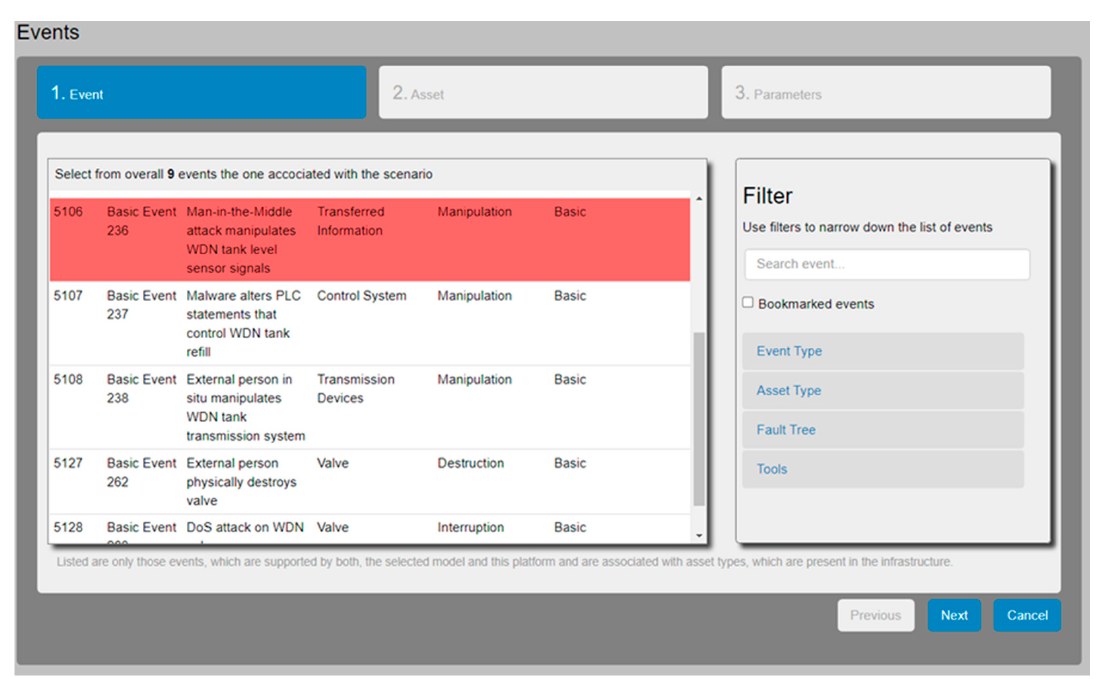
Figure 8. Selection of the risk event of RS 3 proposed by the fault tree within the Scenario Planner.